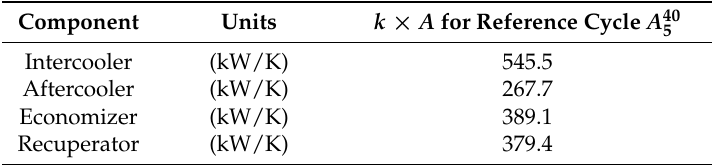
(see also Table 4). 5